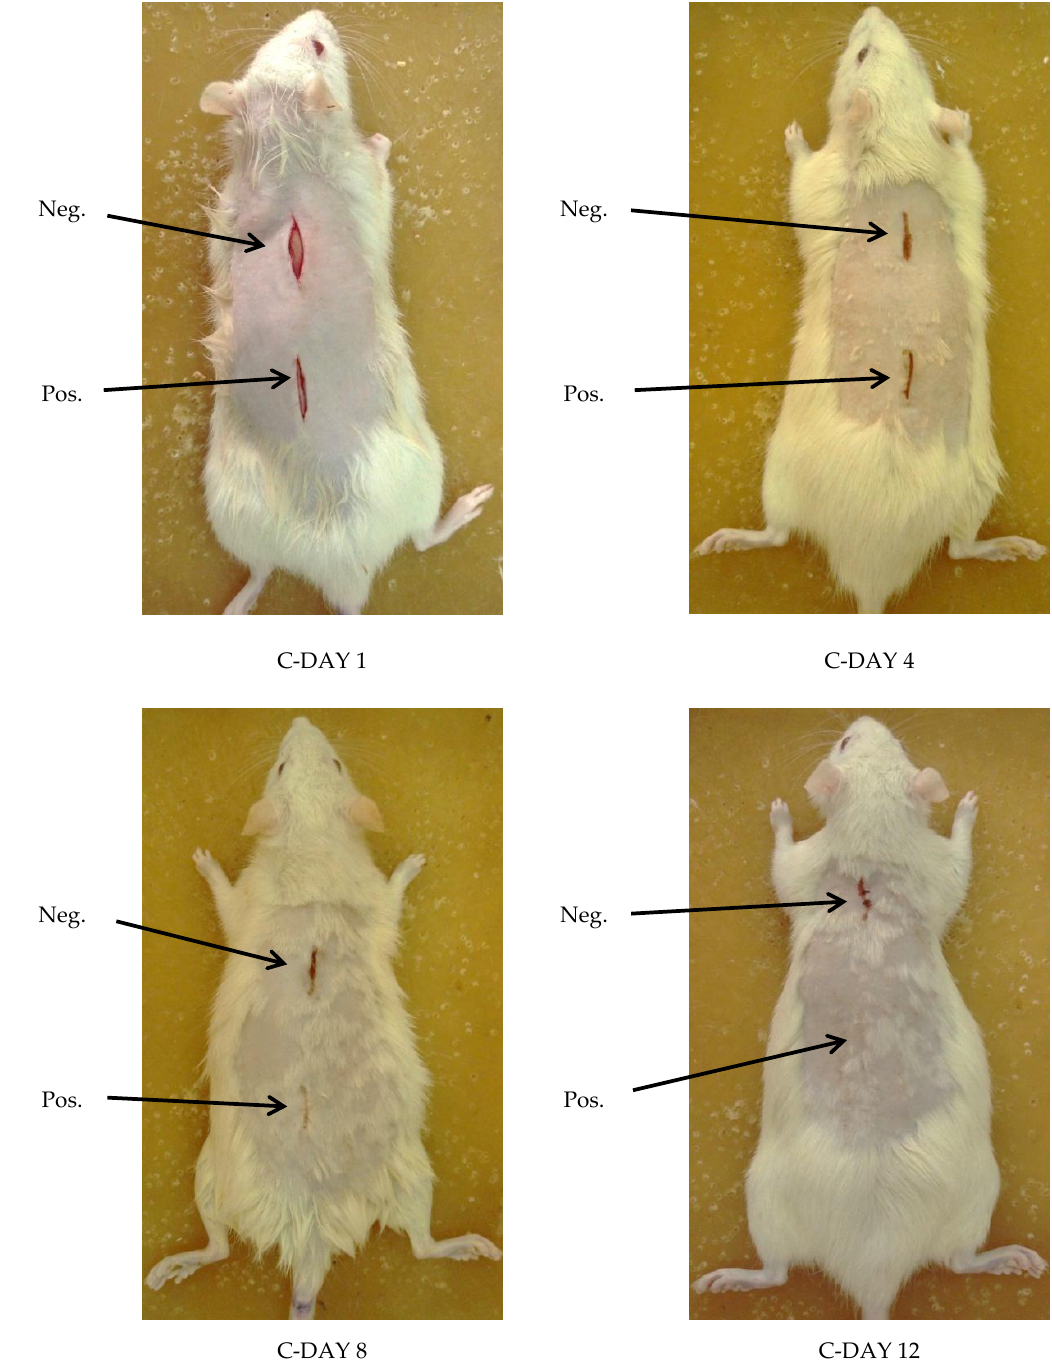
Figure 7. Visual examination of CONTROL group rats at day 1, 4, 8, and 12, where the TOP wound represents negative control ointment (Neg.), and the BOTTOM one represents positive (MEBO) control ointment (MEBO) (Pos.).